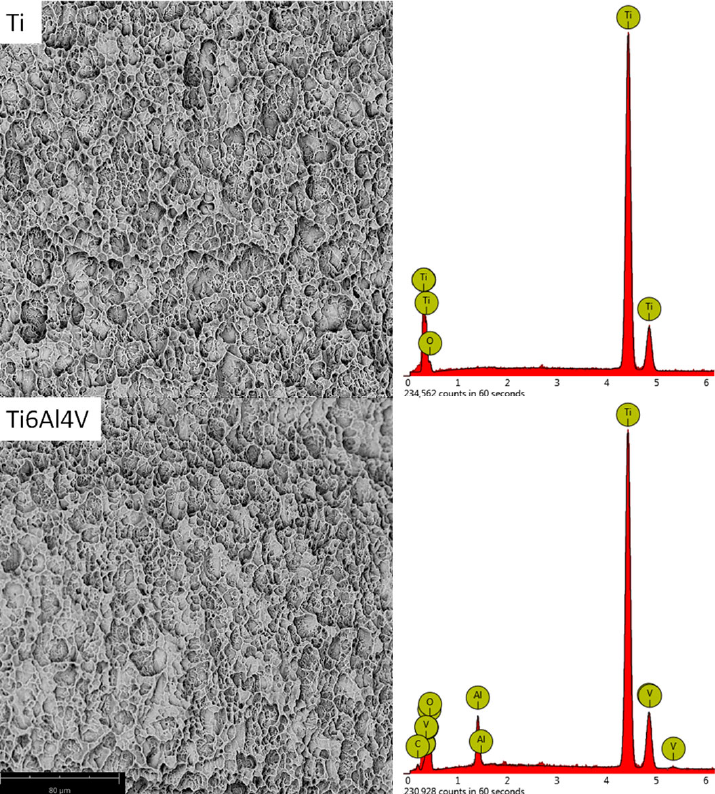
Figure 1. The SEM (scanning electron microscope) images and EDX (energy-dispersive X-ray spectrometer) spectra of Ti and Ti6Al4V samples after sandblasting and etching.